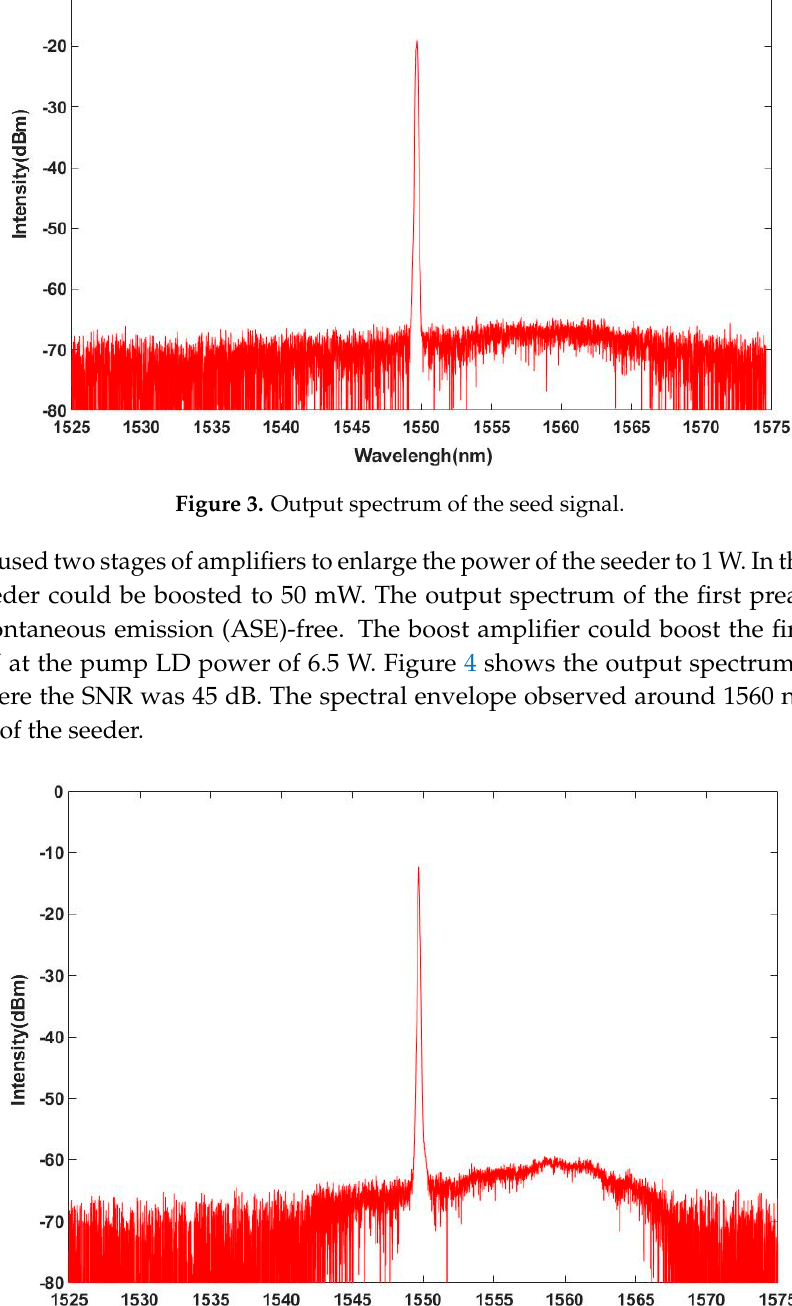
Figure 2. The diagram of the linewidth measurement system.